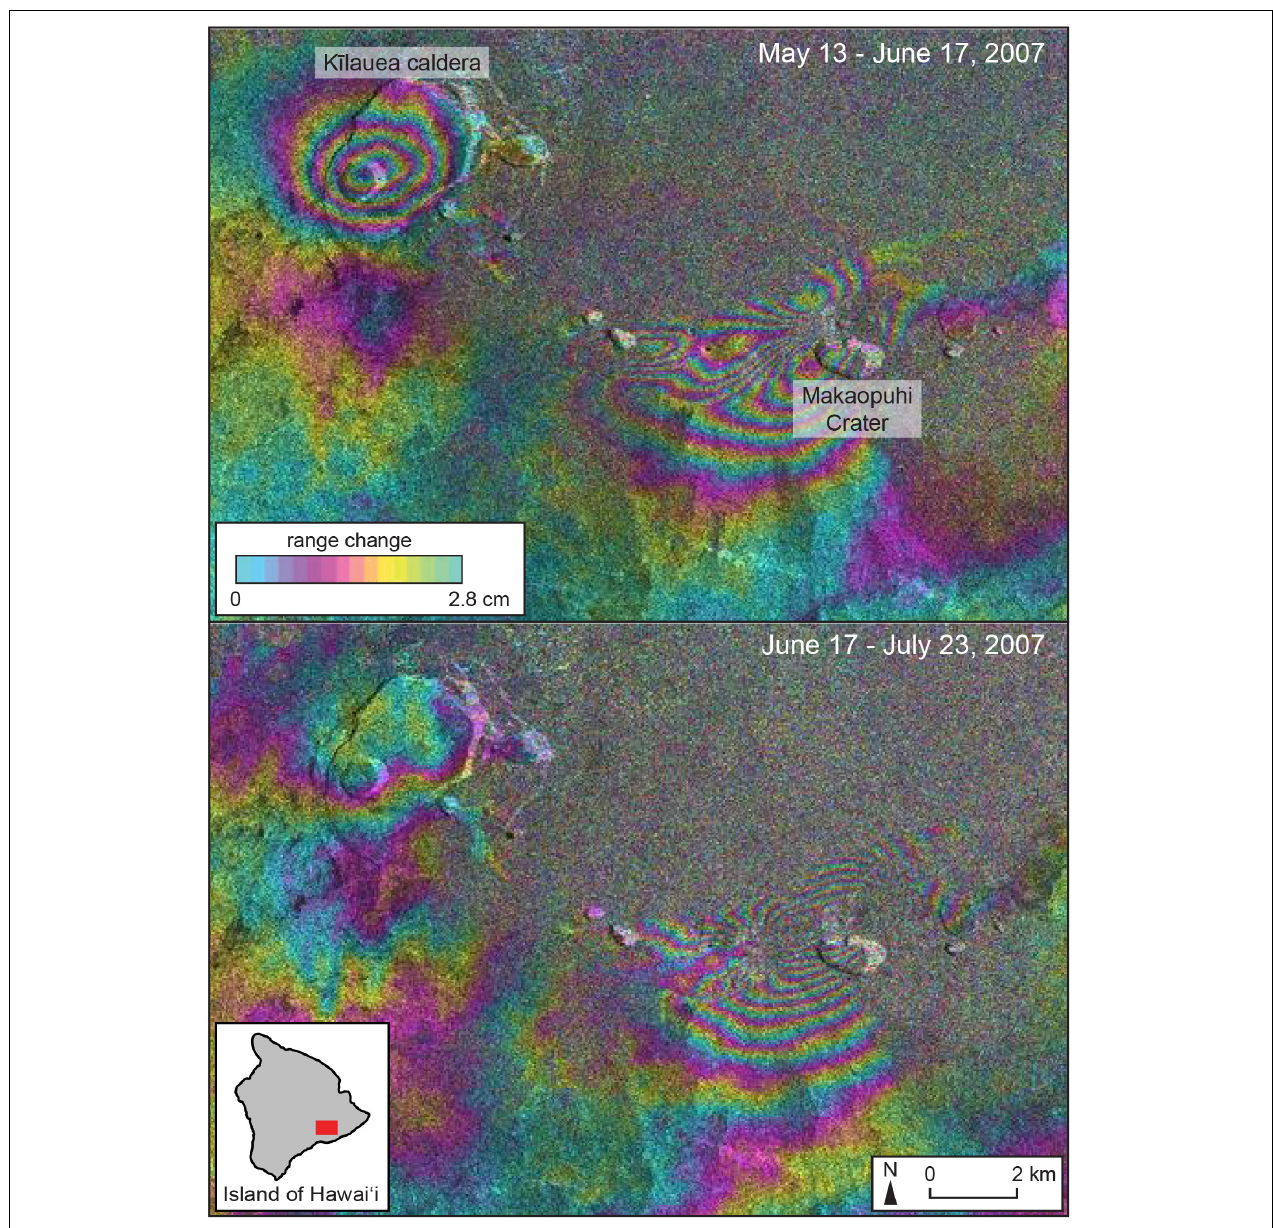
FIGURE 4 | ENVISAT interferograms from beam mode 2, track 93, and spanning the onset (top) and conclusion (bottom) of K¯ılauea’s July 17–19, 2007, East Rift Zone intrusion and eruption. This was one of the first times that a SAR image was acquired of a dike intrusion as it was happening, and the sequence of images provided excellent spatial resolution of how the intrusion evolved over